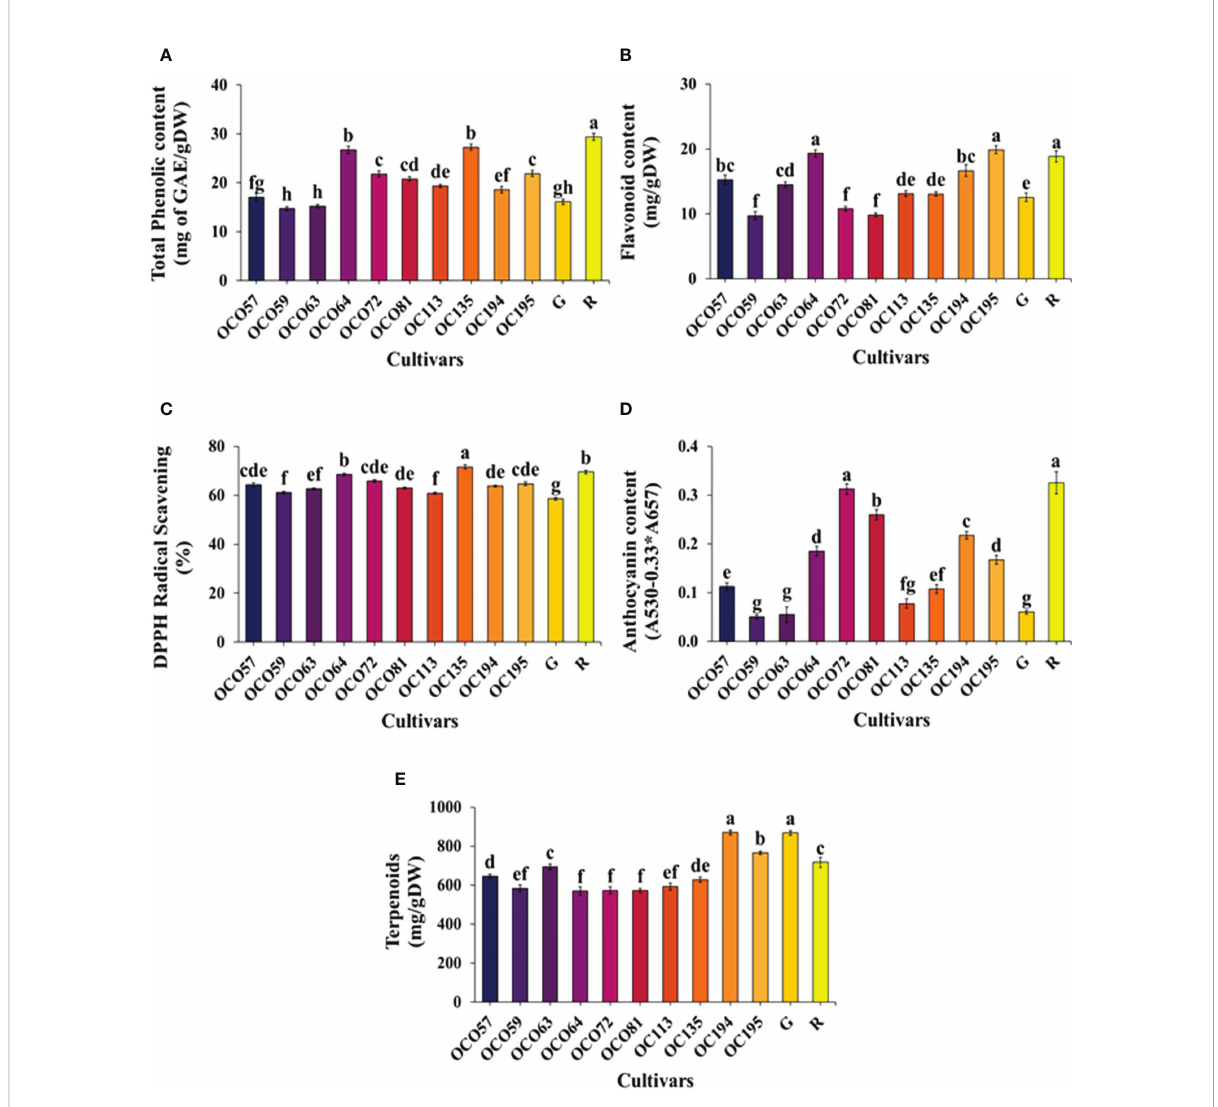
FIGURE 6 The content of total phenolic compounds (TPC) (A) , total fl avonoid content (TFC) (B) , DPPH (C) , anthocyanin (D) , and total terpenoids (E) of Thai holy basil cultivars/accessions at fl owering stage R and G represent the red and green commercial cultivars, respectively. Bars represent standard error. Values are represented as mean ± SE ( n = 4). ANOVA was performed, followed by mean comparison with DMRT. Letters above bars show a signi fi cant difference of means at P <